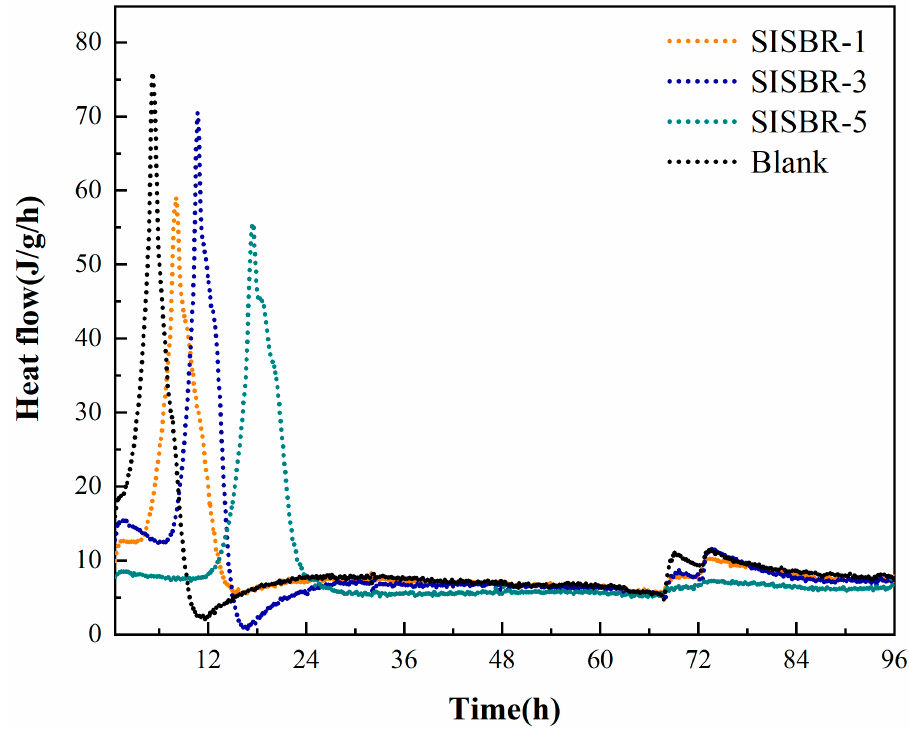
Figure 9. Influences of IA amount of SISBR latex powders on heat evolution of cement hydration.